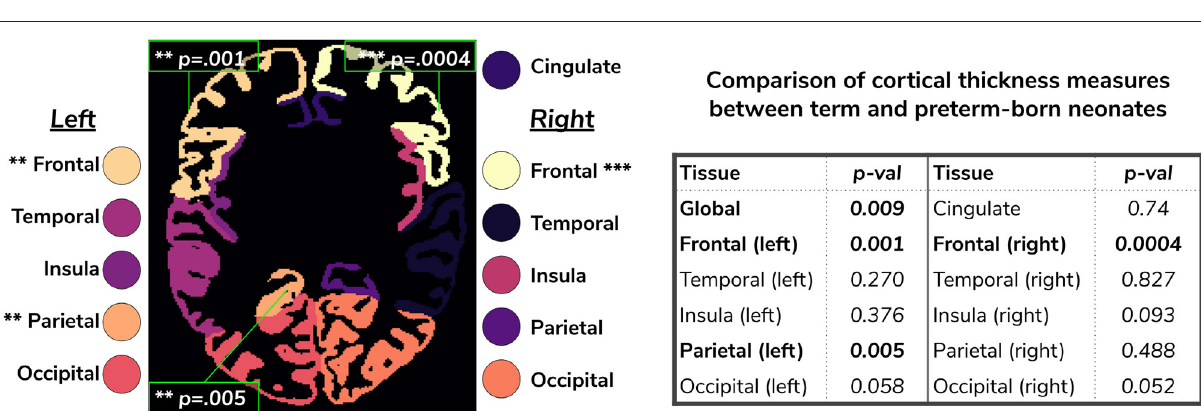
(Sandfort et al., 2019), which made the segmentation